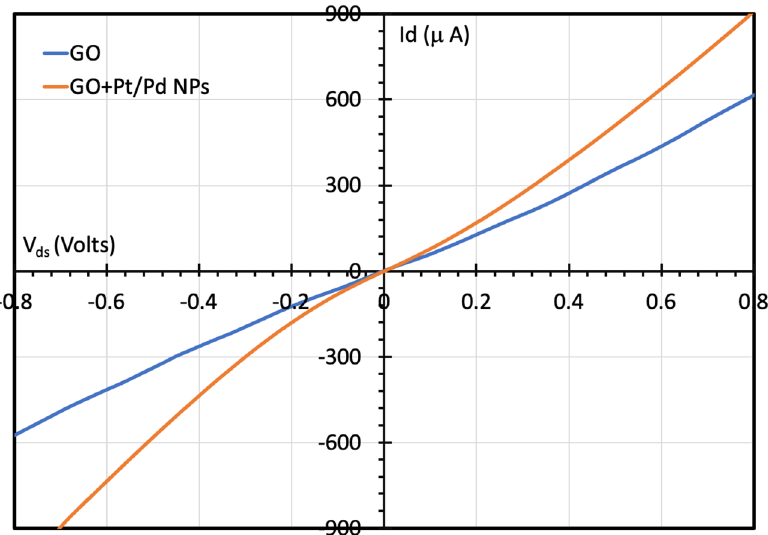
Figure 7. I d − V ds characteristics for both GO sensors: with and without bimetallic nanoparticles.